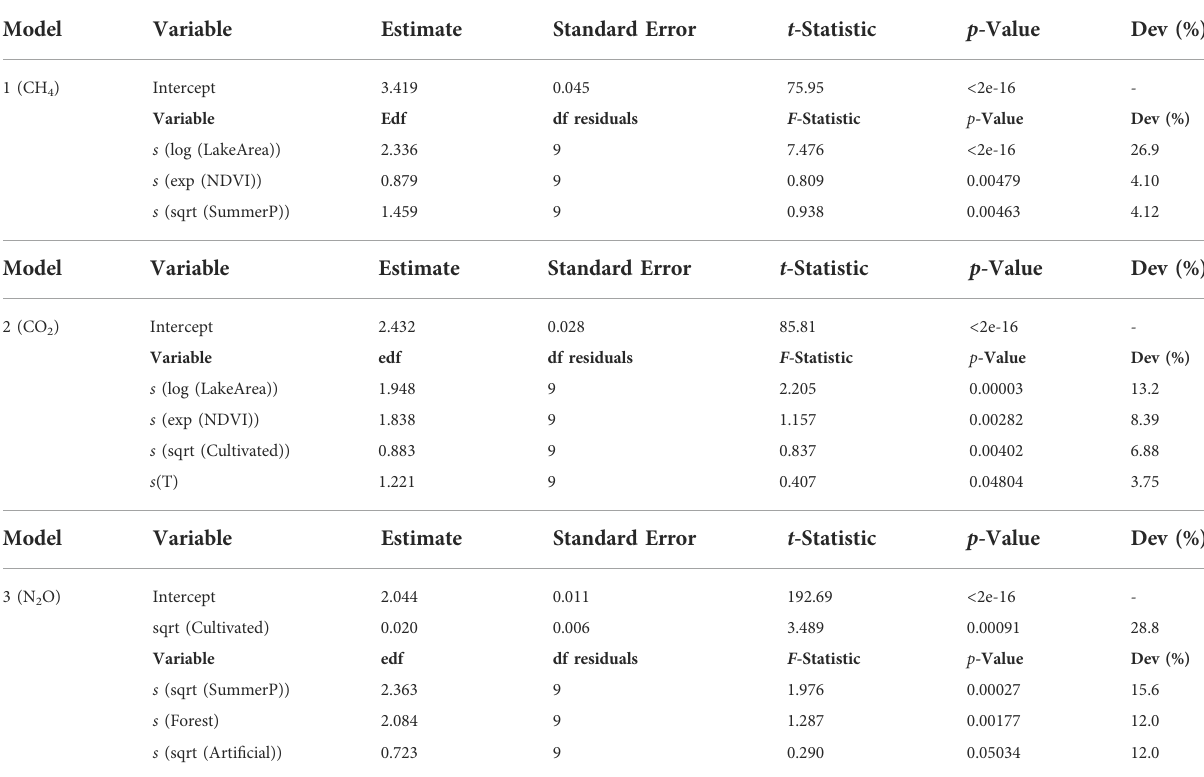
TABLE 2 Output of each generalized additive models (GAM). Edf: effective degrees of freedom. Dev: deviance explained by each factor of the model in %.